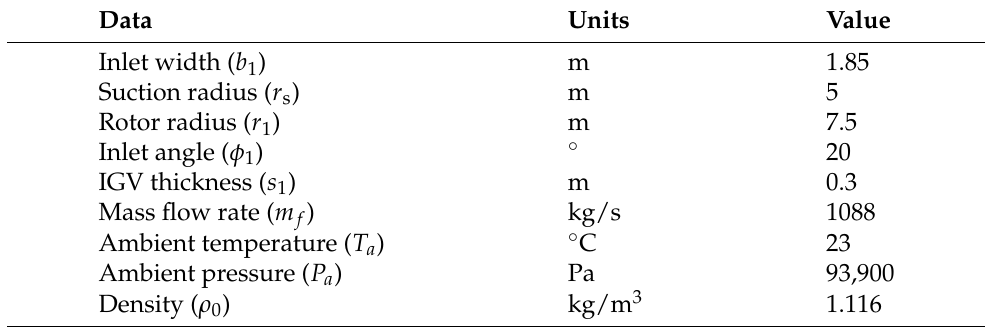
Table 1. Main turbine parameters, from Haaf [1]. See Figures 5 and 6 for